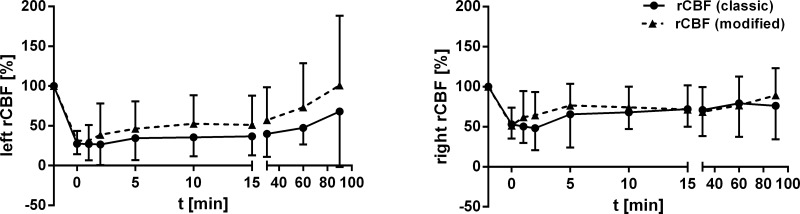
Course of left and right rCBF.Graphs showing percentage changes (mean +/- standard deviation) of left and right rCBF (percentage of baseline).